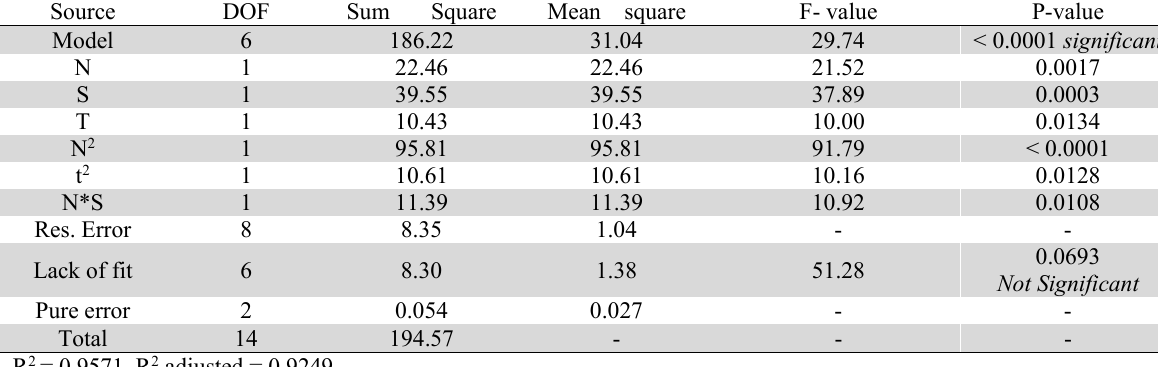
ANOVA table for tool vibration (after backward elimination)